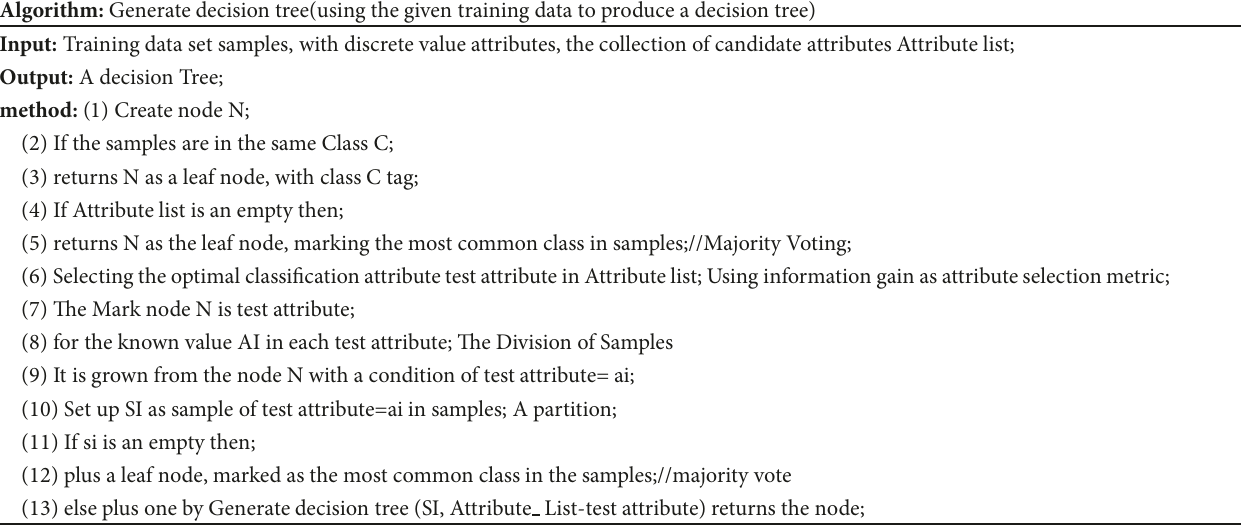
Table 1: The process of generate decision tree (using the given training data to produce a decision tree). A lgorithm : Generate decision tree(using the given training data to produce a decision tree) I nput : Training data set samples, with discrete value attributes, the collection of candidate attributes Attribute list;